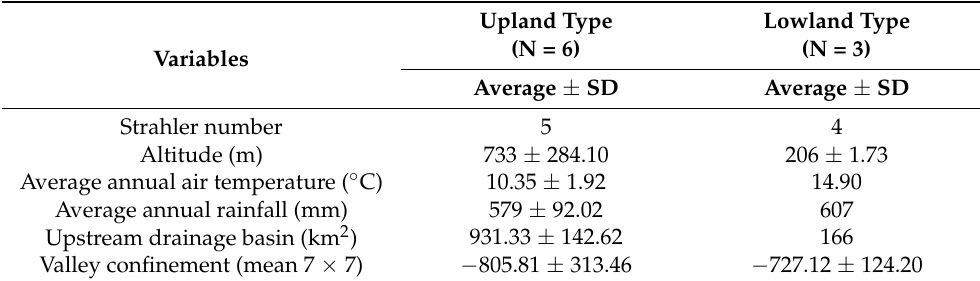
Figure 2. Aerial photo of a sampling site, showing details of the pitfall traps arrangement, riparian vegetation cover delimitation and the riverbank line that worked as a support to create the 200 m half-size buffer radius used to calculate relative measurements of LULC anthropogenic pressures. Table 1. Average and standard deviation (SD) for environmental variables of the two river types surveyed, i.e., upland and lowland (number of sites are